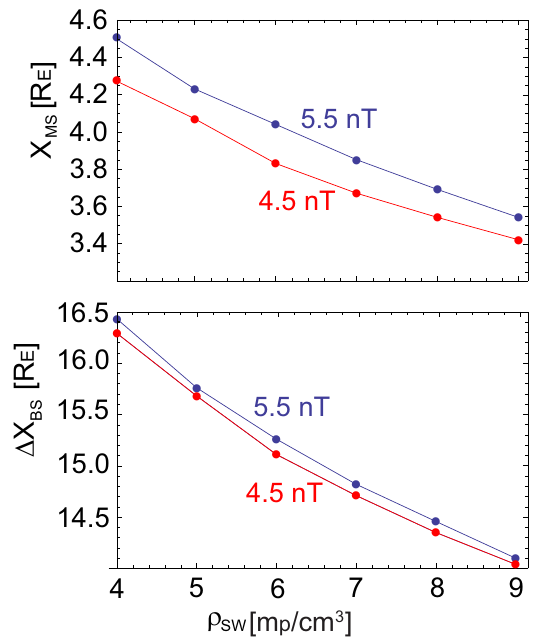
Fig. 10. Calculations of the bow shock distance from the Earth’s center and the magnetopause thickness as a function of the solar wind density, using the second-order approach. Two different solar wind magnetizations, 4.5nT and 5.5nT, were considered.